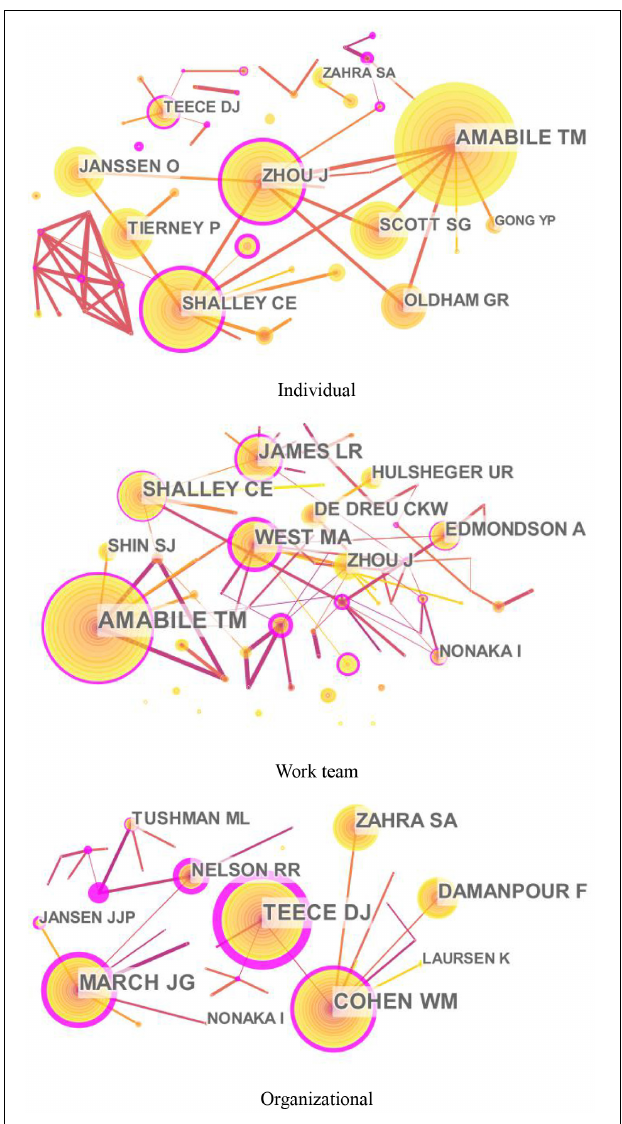
FIGURE 3 | Knowledge maps of the cited authors of innovation research at different